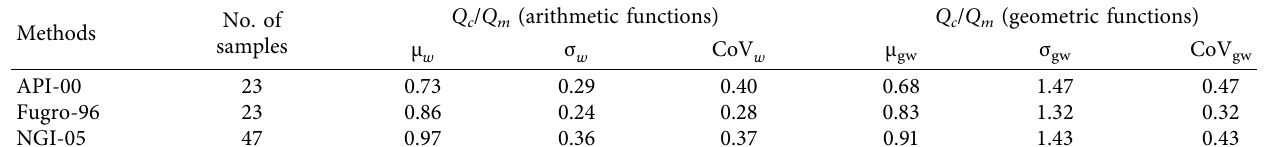
Table 1: Method uncertainties for piles in clay